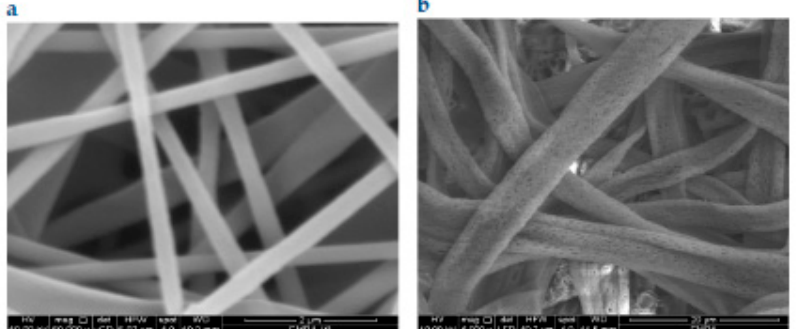
Figure 2. SEM images for the electrospun cellulose acetate nanofibers obtained in: ( a ) DMF and ( b ) dichloromethane (DCM)/acetone mixture.